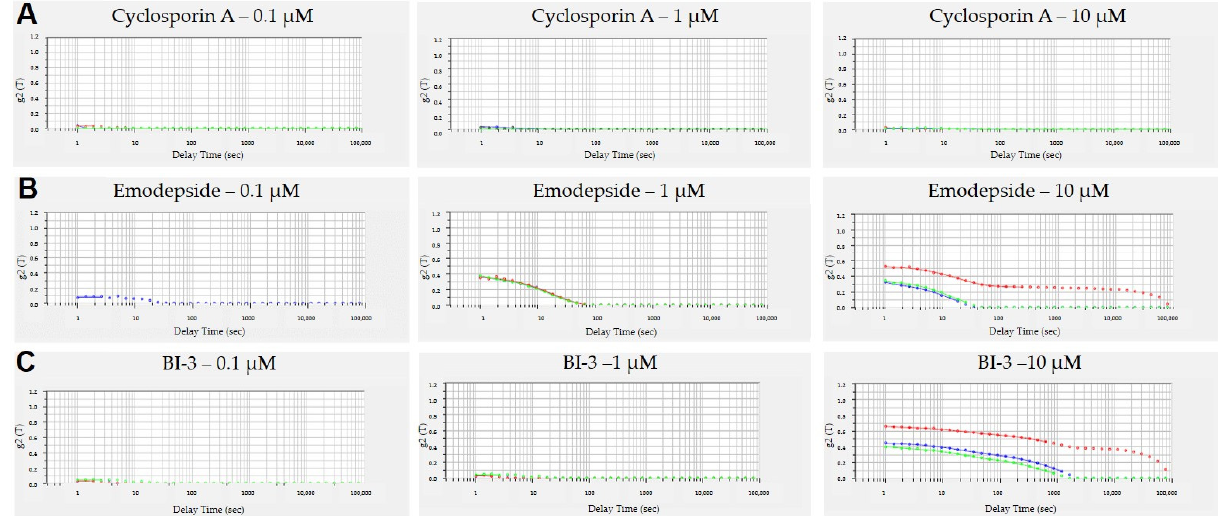
Figure 2. Time correlation functions of ( A ) cyclosporin A, ( B ) emodepside, ( C ) and BI-3 at 0.1 µM, 1 µM, and 10 µM. For each sample, the measurement was recorded in triplicate. Table 3. Bidirectional permeability measured in Caco-2 cells. Data are mean values of duplicates from standard permeability assays. Final concentration of compounds in donor compartment was 1 µM.